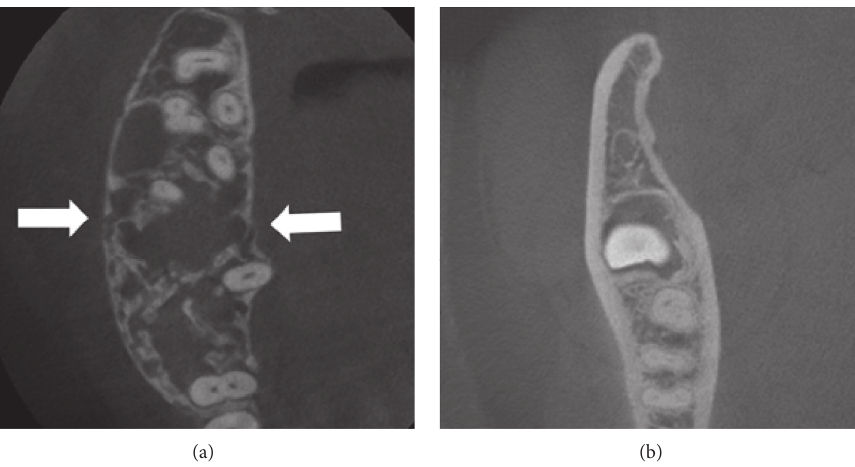
Figure 3: Axial CBCT images. (a) Maxillary odontogenic myxoma (Patient 3) at the dentate area, including more than 3 teeth with bone expansion and perforation (arrows). (b) Mandibular odontogenic myxoma (Patient 9) with unerupted third molar without bone perforation.